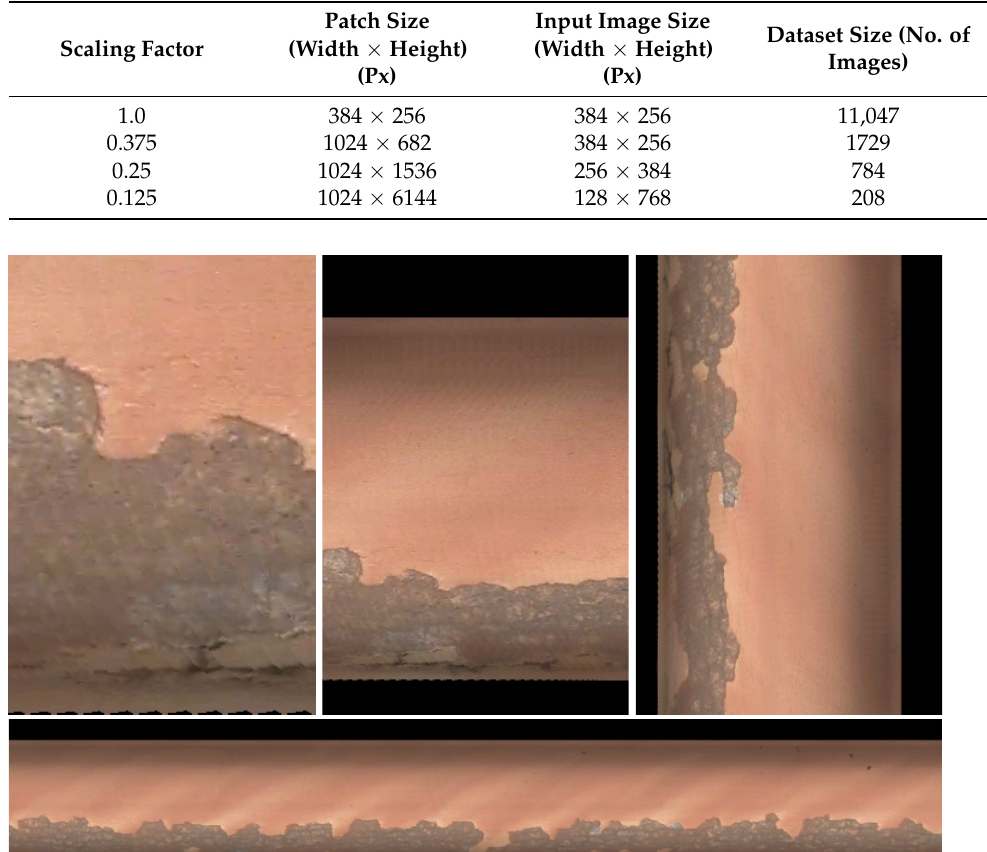
Table 1. Patch sizes to be evaluated. All scaling factors (lower than 1.0) and input image sizes were selected to achieve an identical number of input pixels while covering the whole width of the overview images. For example images, see Figure 2.